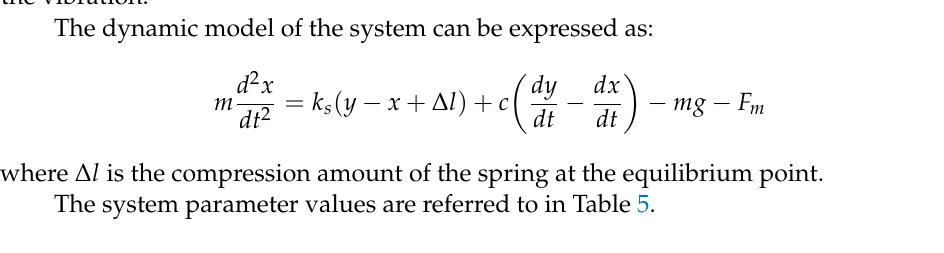
Table 5. The system parameters.